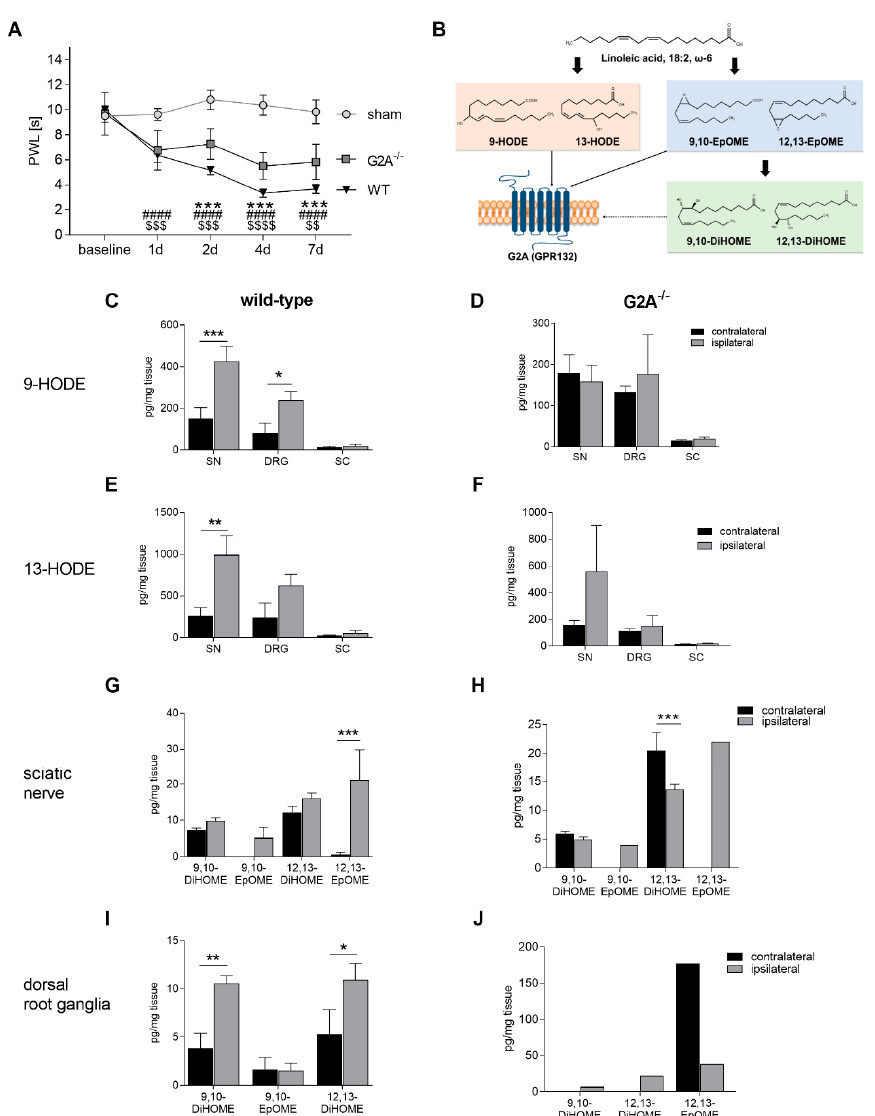
Figure 1. GPR132 (G2A)-deficiency leads to reduced mechanical hypersensitivity and the secretion of oxidized lipids is affected in wild-type mice. ( A ) Paw withdraw latency (PWL) of ipsilateral site of wild-type mice (WT, triangle), G2A-deficient mice (G2A − / − , squares) and sham-treated mice (circles) after spared-nerve injury (SNI) surgery. n = 10 animals, male and female, * p < 0.05, ** p < 0.01, *** p < 0.005, **** p < 0.001 (WT vs. G2A − / − ); ### p < 0.005, #### p < 0.0001 (WT vs. sham); $$ p < 0.01, $$$ p < 0.005, $$$$ p < 0.0001 (G2A − / − vs. sham). Statistics were performed with two-way Analysis of variance (ANOVA) with Bonferroni correction. ( B ) Schematic depiction of the oxidative linoleic acid pathway. ( C , D ) Concentrations of 9- hydroxyoctadecadienoic acid (HODE) in sciatic nerve (SN), L4–L6-dorsal root ganglia (DRG) and spinal cord (SC) in wild-type ( C ) and G2A-deficient (G2A − / − ) ( D ) mice 7 days after SNI surgery. ( E , F ) Concentrations of 13-HODE in sciatic nerve (SN), dorsal root ganglia (DRG) and spinal cord (SC) in wild-type ( E ) and G2A-deficient (G2A − / − ) ( F ) mice 7 days after SNI surgery. ( G – J ) Concentrations of epoxyoctadecenoic acids (EpOMEs) and dihydroxyocatadecenoic acids (DiHOMEs) in SN ( G , H ) and DRG ( I , J ) in wild-type ( G , I ) and G2A − / − ( H , J ) mice 7 days after SNI surgery. Black represents untreated site (contralateral). Grey represents treated site (ipsilateral) in the respective tissues from n = 5 mice per group, male and female. Data represent mean ± standard error ofmean (SEM). * p < 0.05, ** p < 0.01, *** p < 0.005; Two-way ANOVA with the Holm-Sidak